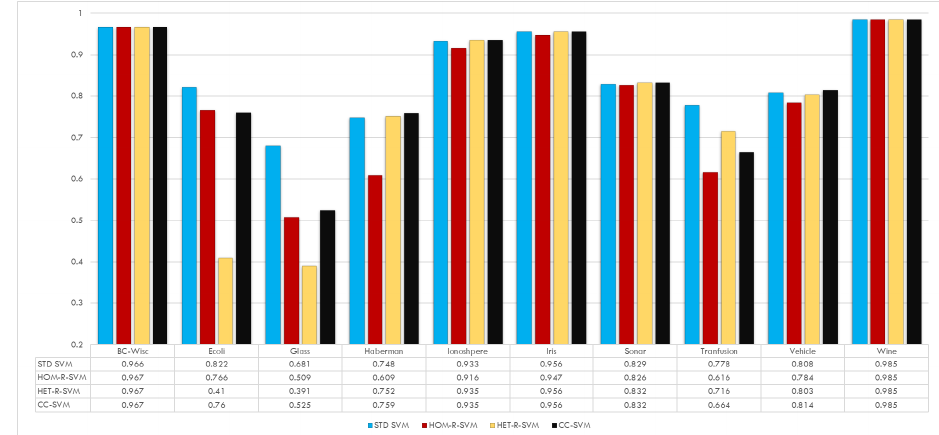
Figure 6. Best Accuracy chart for proposed